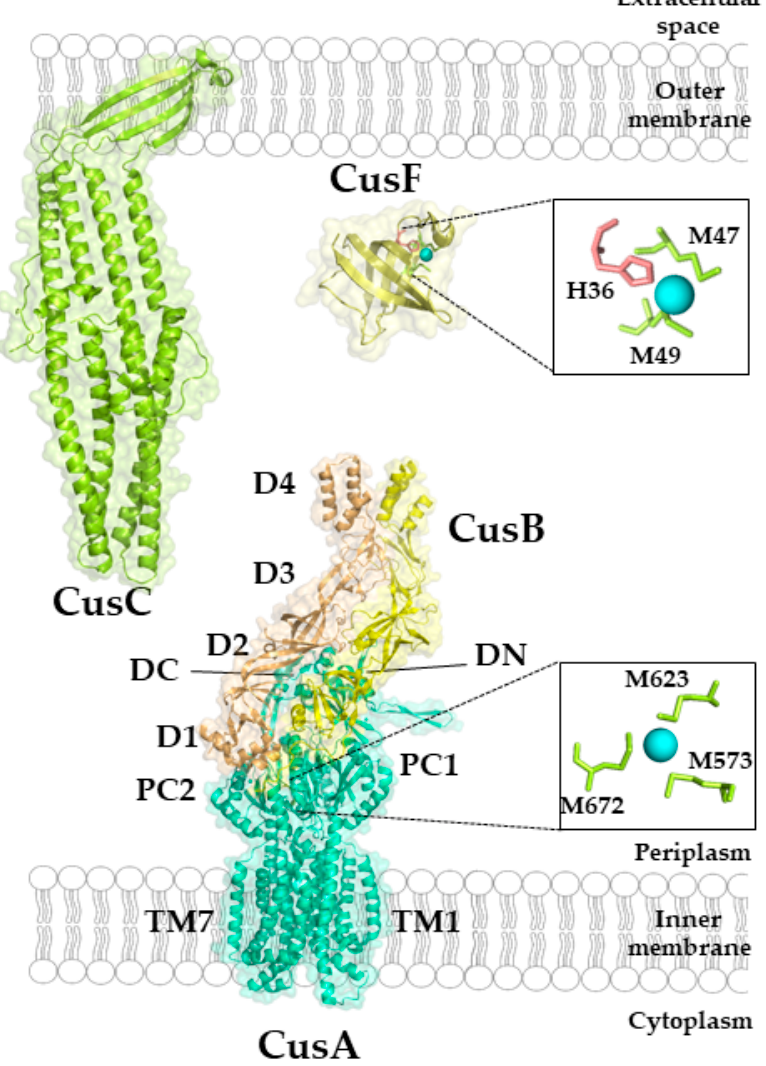
Figure 9. The CusABC system for Cu export. CusA is an integral membrane protein that binds two CusB copies to form a CusA 3 -CusB 6 complex. The methionine triad for Cu / Ag binding in CusA is depicted in the insert. CusC is the outer membrane component that forms a trimer in the outer membrane and interacts with CusB. However, the complete structure of the CusA 3 B 6 C 3 complex has not been solved yet. The CusA 3 B 6 C 3 complex can transport Cu from the cytoplasm into the extracellular space but can also receive Cu from the periplasmic Cu chaperone CusF, which binds Cu via methionine and histidine residues (insert). Structures were retrieved from the protein database (PDB) with the following IDs: 3KSS (CusA), 3NE5 (CusBA), 4K7R (CusC), 2VB2 (CusF), and depicted using Pymol.